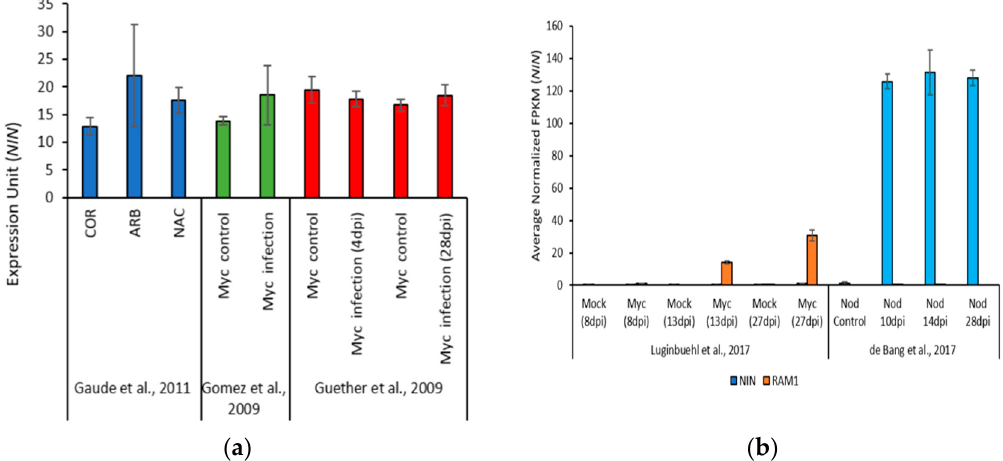
Figure 2. Expression of Nodule Inception ( NIN ) during AM symbiosis and nodulation. Quantification of NIN expression ( a ) using publicly available transcriptome data (microarray). Raw data were retrieved from the Medicago truncatula Gene Expression Atlas [31] and the Lotus japonicus Gene Expression Atlas [32]. Data from three independent experiments are shown. The chart on the left shows NIN expression in di ff erent cell types of M. truncatula , collected using laser capture microdissection (LCM) 3 weeks after inoculation with R. irregularis . Data are from Gaude et al. [33]. In Gomez et al. [34] chart, NIN expression in 6-week-old M. truncatula uninoculated and R. irregularis inoculated roots is shown. Guether et al. [35] data represent NIN expression in uninoculated and Gigaspora margarita inoculated roots of Lotus japonicus at two di ff erent time points 4- and 28-days post inoculation (dpi). COR-cortical cells of non-mycorrhizal roots, ARB-arbuscule-containing cells and NAC-non-colonized cortical cells of mycorrhizal roots. Error bars represent standard error of the mean; ( b ) Quantification of NIN expression using publicly available transcriptome data (RNAseq). Raw data were retrieved from M. truncatula Small Secreted Peptide Database [38]. The expression of NIN and RAM1 at di ff erent time points post inoculation with R. irregularis along with their respective mock inoculated controls was compared; data are from Luginbuehl et al. [37]. The expression of NIN and RAM1 at varying developmental stages of nodulation was compared; data are from de Bang et al. [36]. Error bars represent standard error of the mean.